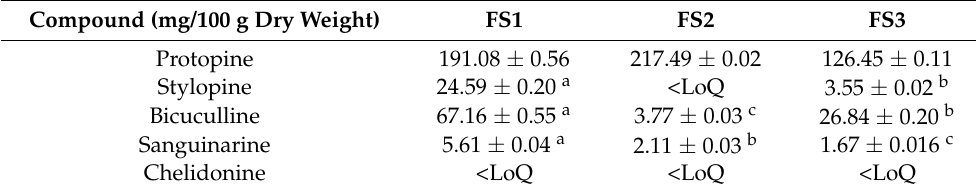
Table 3. Quantification of alkaloids in the tested F. schleicheri samples.